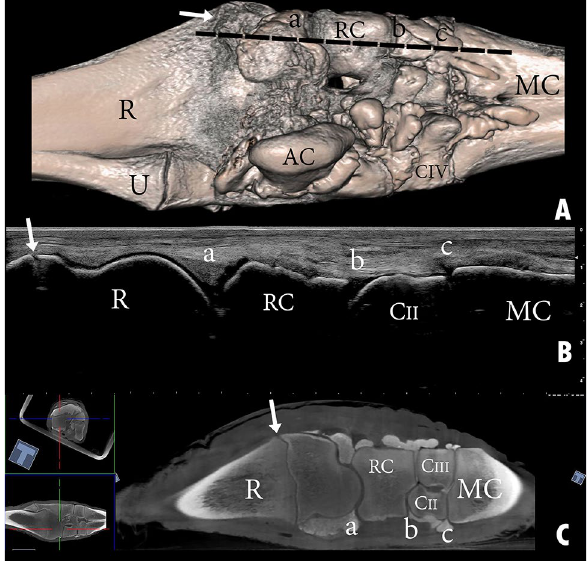
Figure 15. Palmar view of a left carpal joint showing ( A ) three-dimensional reconstruction of the carpal joint (the black dotted line indicates the palmomedial placement of the ultrasound probe); ( B ) longitudinal composed ultrasound image of the carpal joint; ( C ) sagittal plane computerized tomography image. R, the distal end of the radius; U, the distal end of the ulna; AC, accessory carpal bone; RC, radiocarpal bone, CII, carpal bone II; CIII, carpal bone III; CIV, carpal bone IV; MC, metacarpal bone; a, radiocarpal joint cavity; b, intercarpal joint cavity; c, carpometacarpal joint cavity. The white arrow indicates the epiphysial